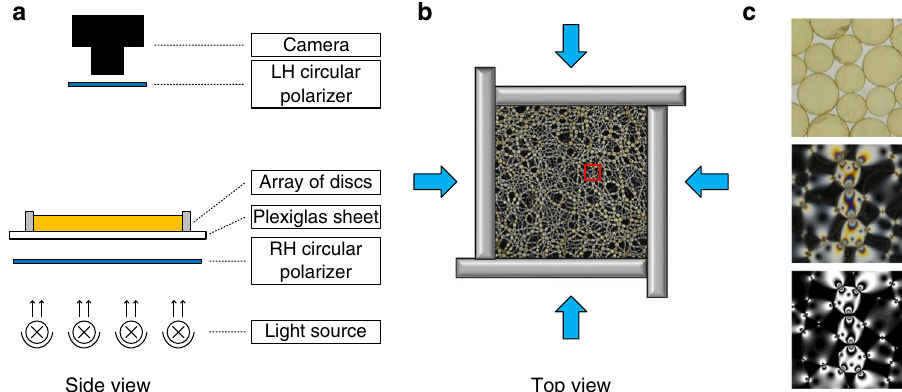
Fig. 1 Schematic of the experimental setup. a Side view of the setup. b Top view of the setup, which includes a square frame fi lled with ∼ 1300 bidisperse photo-elastic disks with a number ratio of 1:1 and a size ratio of 1.4:1. The four thick blue arrows represent the isotropic compression applied by simultaneously moving the four walls inwards. The small red square included in the stress image of a highly jammed packing contains a small portion ampli fi ed in c . c Top: image taken without a polarizer to record the packing ’ s con fi guration. Middle: corresponding stress image. Bottom: reconstructed stress image taken from the measured contact